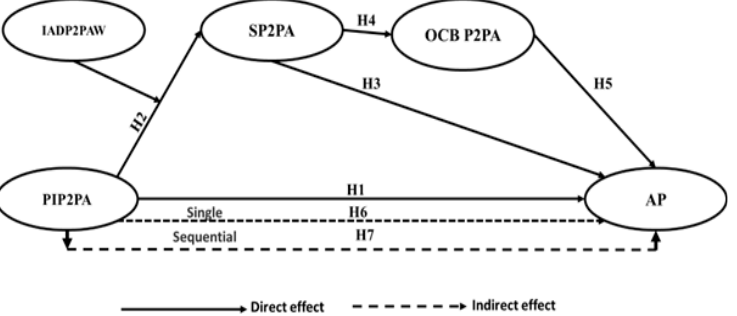
Figure 1. The proposed conceptual framework and hypotheses. PIP2PA → Positive Impacts of P2PA; AP → Agritourism performance; SP2PA → Support for P2PA; OCBP2PA → Organizational Citizenship Behavior toward P2PA; IADP2PAW → Information on Agritourism Destination on the P2PA website.